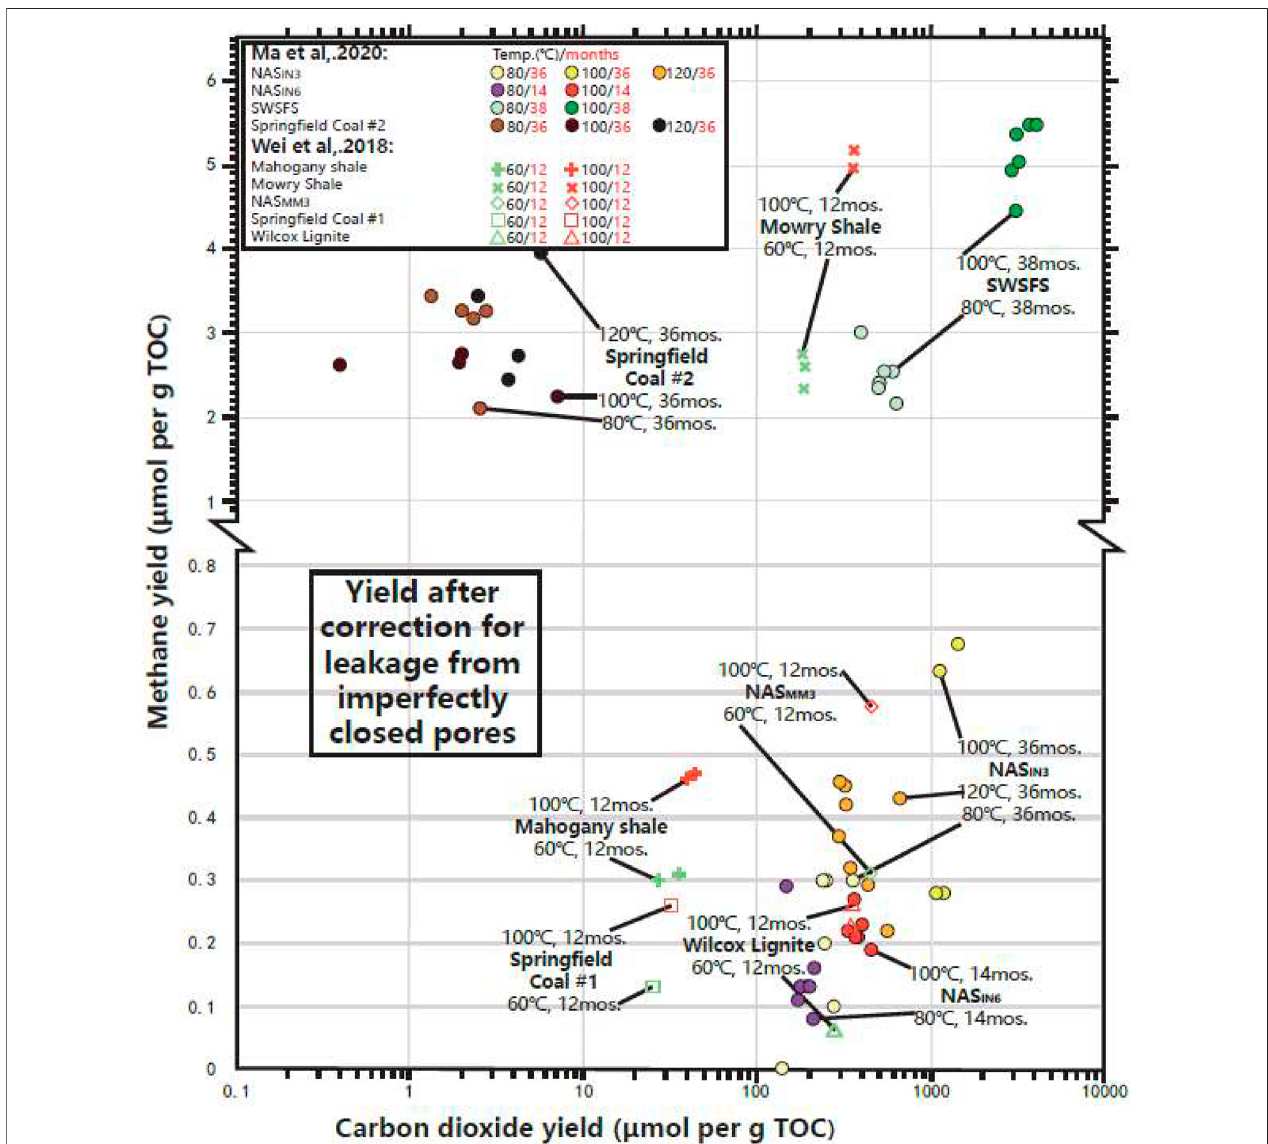
FIGURE 2 | Gas generation yields from previous heating experiments were gathered and presented. Data used in this study were re-calculated results from earlier data reported by Wei et al. (2018) and Ma et al. (2021). Final catalytic gas generation yields in this study were quanti fi ed using the total yields of released gas from glass ampoules and residual gas in closed pores from source rock chips after heating experiments deducting yields of residual gas in closed pores of original un-heated samples. The CO 2 scale is logarithmic. The reproducibility of methane and CO 2 yields was limited by the analytical uncertainty of quanti fi cation of ±0.007 μ mol g − 1 and ±0.3 μ mol g − 1 , respectively. SWSFS, Second White Specks Formation Shale.